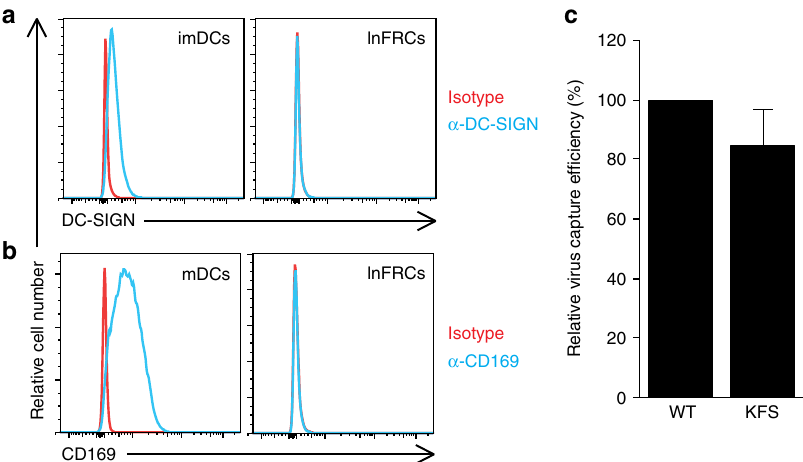
Fig. 4 FRCs mediate trans-infection in a DC-SIGN- and CD169-independent mechanism. a Flow cytometry analysis of DC-SIGN expression on the surface of lnFRC and immature DC (imDC), the latter of which serves as a positive control. b Flow cytometry analysis of CD169 expression on the surface of lnFRC and mature DC (mDC), the latter of which serves as a positive control. c Quanti fi cation of the amount of HeLa-derived WT and KFS (Env − ) HIV-1 NL4-3 captured by lnFRCs. lnFRCs were cultured in the presence of HIV-1 NL4-3 (7.6 ng p24) for 2 h and washed extensively. The amount of virus captured by lnFRCs was quanti fi ed by p24 ELISA assays. Similar results were obtained using lnFRCs isolated from three different donors. Data represent the mean ± SD of three independent experiments